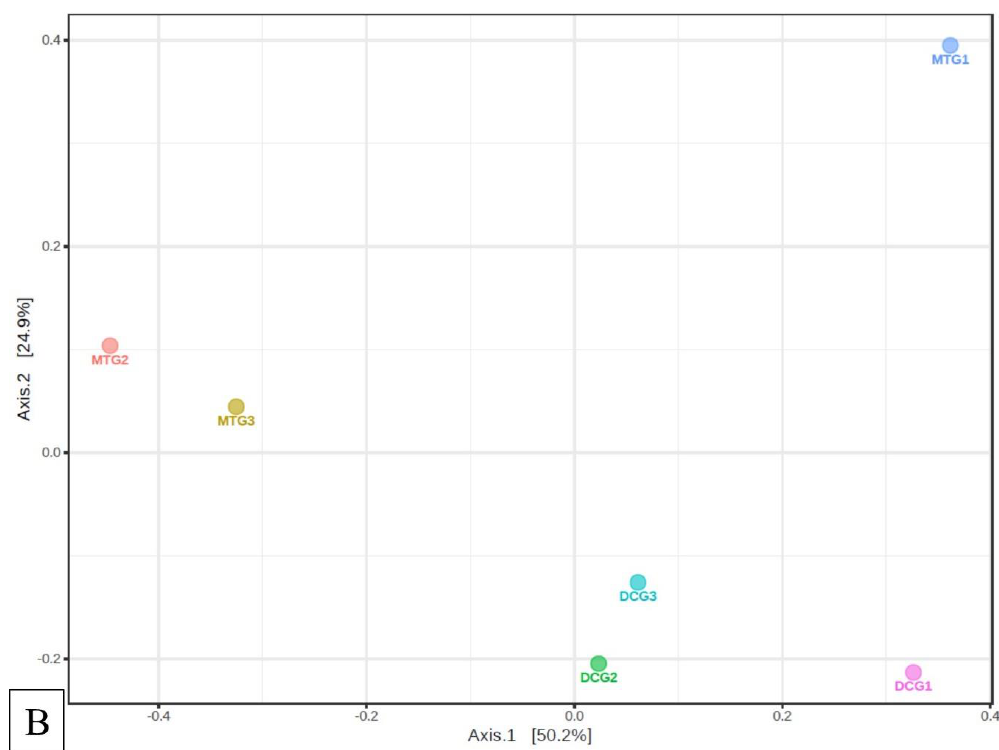
Figure 8. Shown are the α ( A ) and β diversity ( B ) analysis and significance testing between the soils and DC/MT chambers. A [PERMANOVA] R-squared: 0.9976; p -value < 0.066667 was obtained from this analysis.